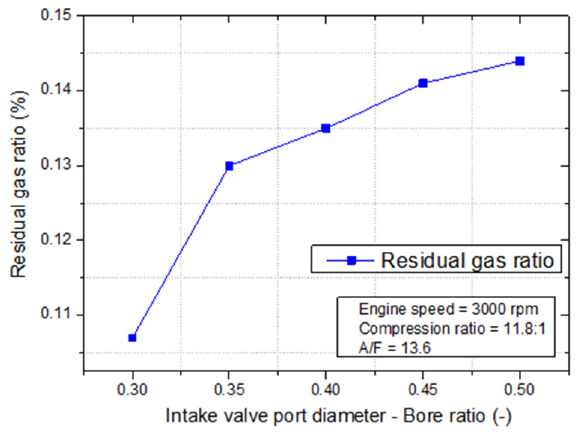
Figure 5. Residual gas versus IPD/B.